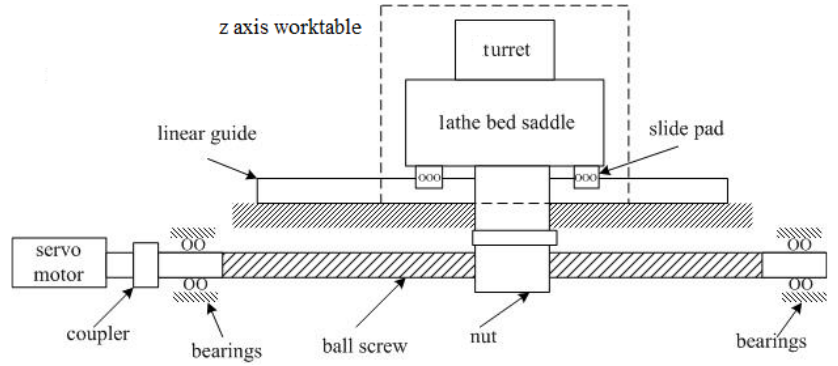
Figure 4. Servo feed drive system for a lathe along the